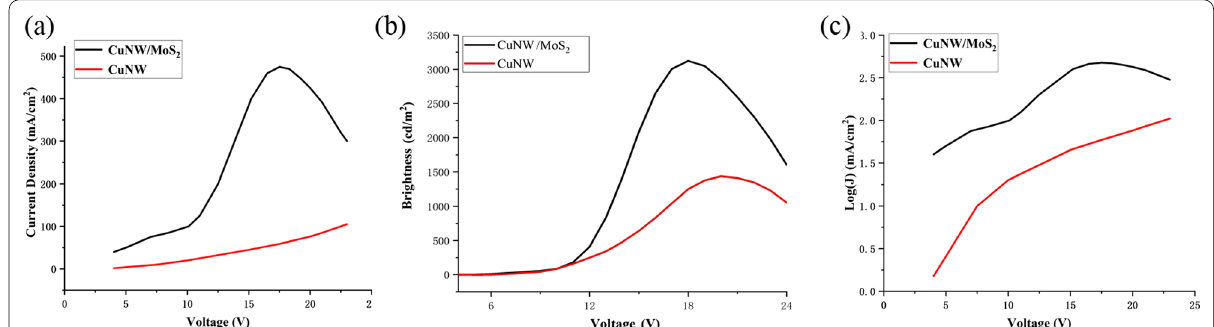
Fig. 10 Current density and Brightness of the OLED with MoS 2 anode buffer layer and the OLED without MoS 2 anode buffer layer: a current density- Voltage characteristics, b brightness characteristics, c current density in log scale versus voltage